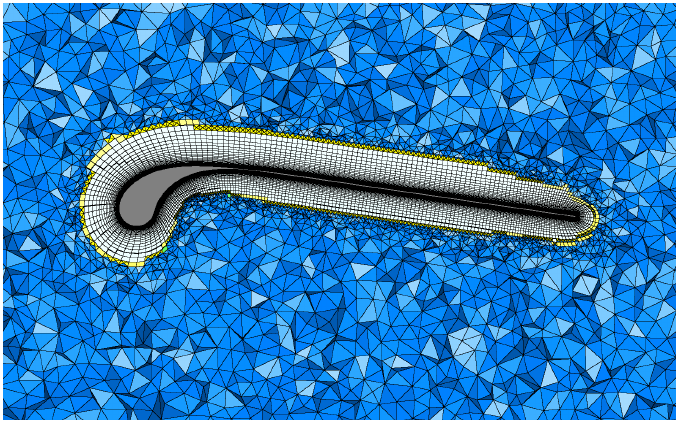
Figure 5. Volume mesh in the symmetry plane ( Z = 0), taken from [23]. A mesh convergence study was performed on five different meshes with cell counts on the wing surface ranging from 10.9 × 10 6 down to 5.67 × 10 6 . Coarser meshes of good quality were difficult to generate. The computed lift and drag coefficients of the wing were nearly constant across these mesh resolutions. For example, for a Reynolds number of 3 × 10 6 , an angle of attack α = 12 ◦ and a side-slip angle β = 0 ◦ , the lift and drag coefficients varied by less than 1% and 2.9%, respectively. The Reynolds number is defined here as Re = U ∞ c / ν , and the lift and drag coefficients as C L = 2 L / ( ρ U 2 ∞ A ref ) and C D = 2 D / ( ρ U 2 ∞ A ref ) , respectively, where U ∞ is the undisturbed flow velocity, c the chord length in the symmetry plane, ν the kinematic viscosity, L the lift force, D the drag force, ρ the fluid density, and A ref the projected area of the design geometry of the wing onto the XZ -plane illustrated in Figure 1 (bottom left). Taking into account the findings of the mesh convergence study, the mesh used for the simulations without side-slip (hemispherical